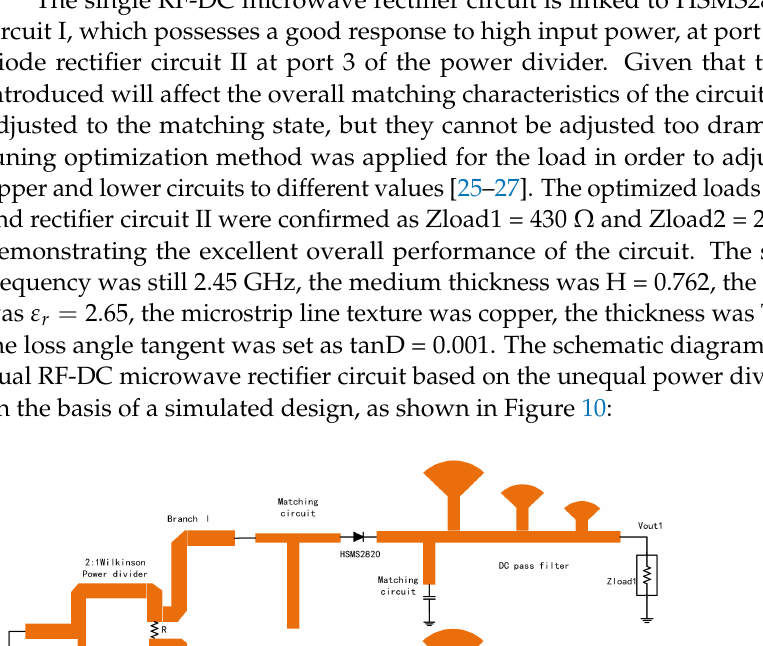
load and real output voltage at circuit 1 were respectively set up as Zload1 and